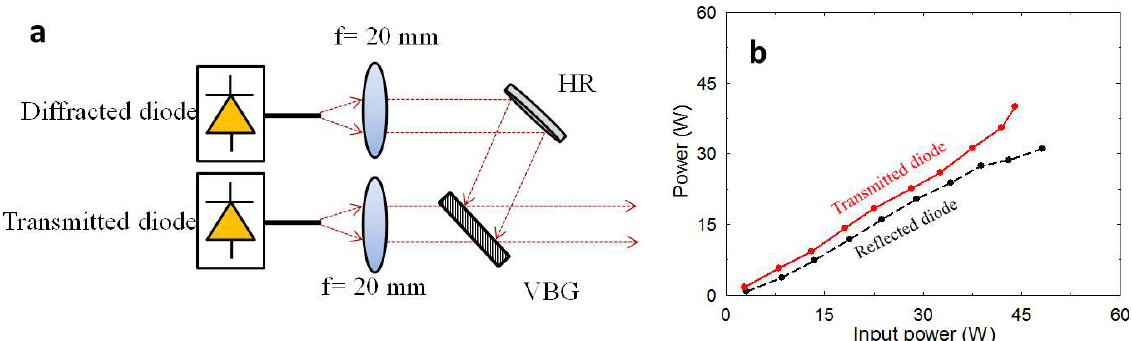
Figure 1. ( a ) Experimental setup of the spectrally beam-combined diode pump source; ( b ) Reflected and transmitted pump power after VBG vs. input power of each